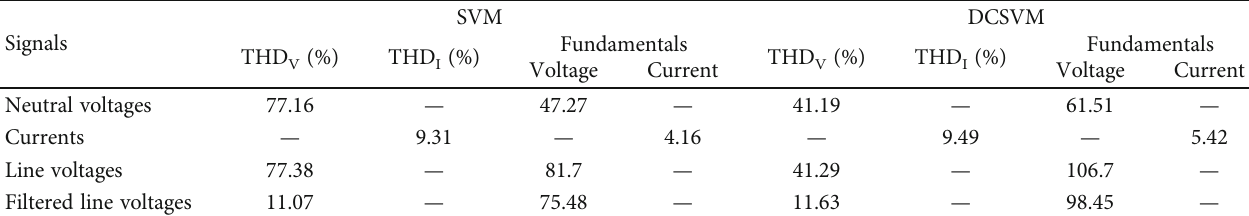
Figure 13: Filtered line voltages ( V Table 4: Comparison of the results obtained at the output of the